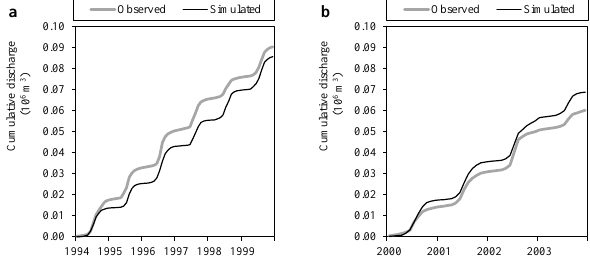
Fig. 8. Comparison of measured and simulated cumulative daily flows for (a) calibration and (b) validation